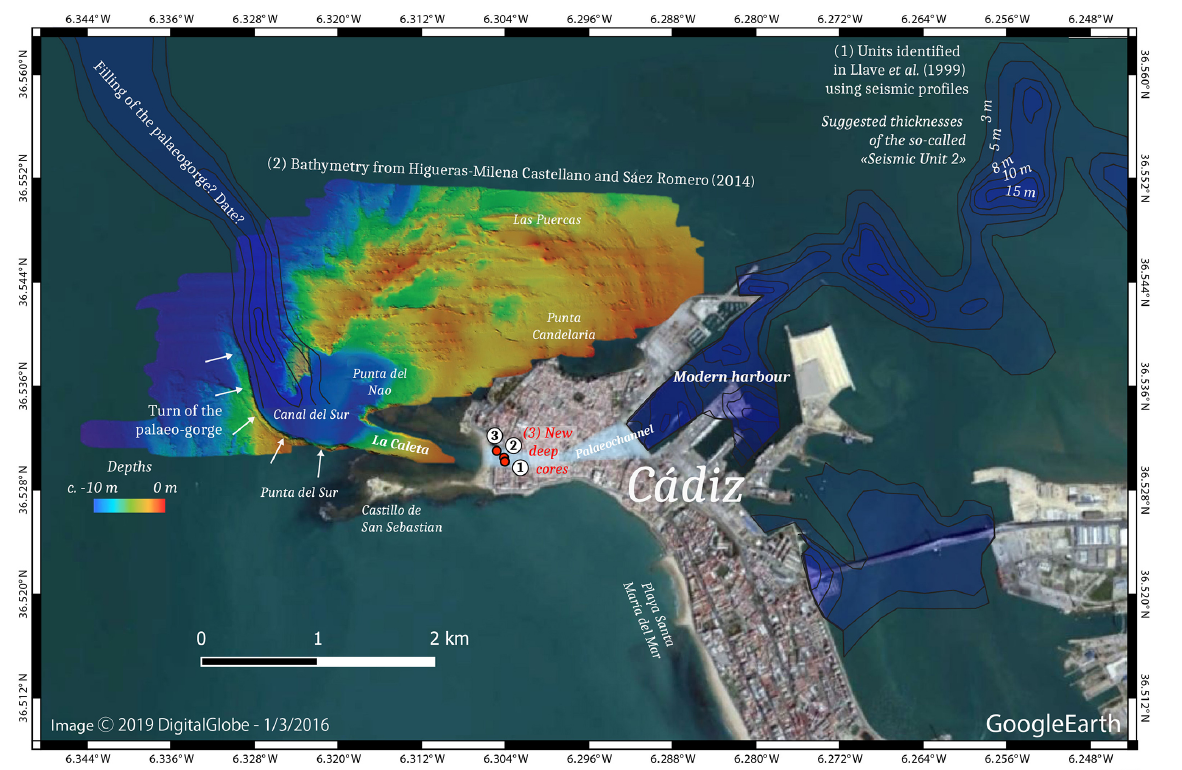
Figure 2. Palaeogorge of Cádiz – evidence from (1) seismic profiles possibly recording the filling of the palaeogorge of Cádiz (Llave et al., 1999); (2) bathymetric data showing a turn of the palaeogorge west of Cádiz (Higueras-Milena Castellano and Sáez Romero, 2014); and (3) new deep cores in Cádiz (this